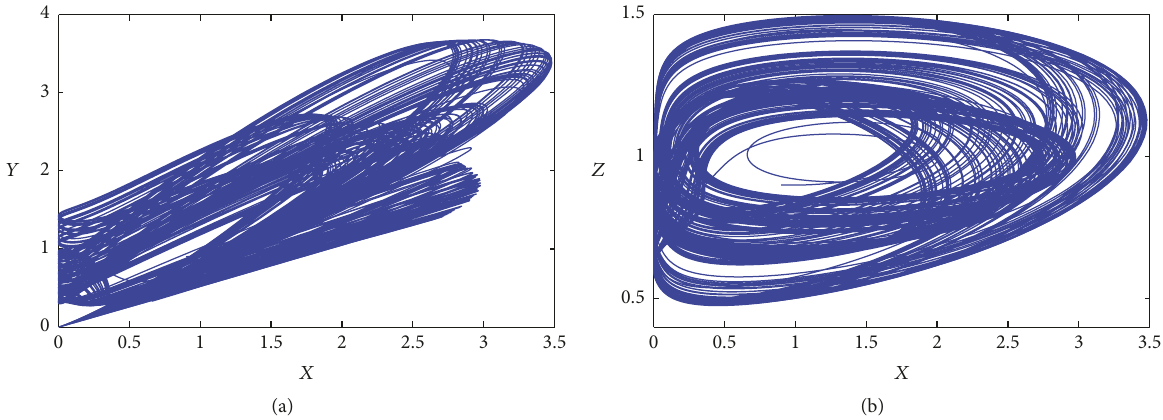
Figure 6: The solution on a phase diagram for 𝛼 = 500 , 𝑅 = 75 , 𝜎 1 = 6.2 , and 𝜂 = 0 . 𝑌 versus 𝑋 (a) and 𝑍 versus 𝑋 (b).